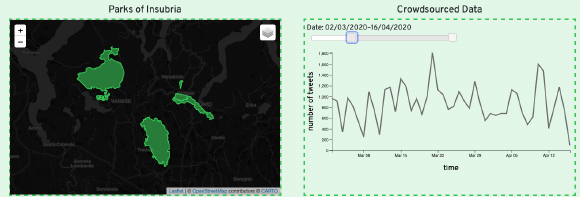
Figure 5. Prototype interface of the INSUBRI.PARKS web